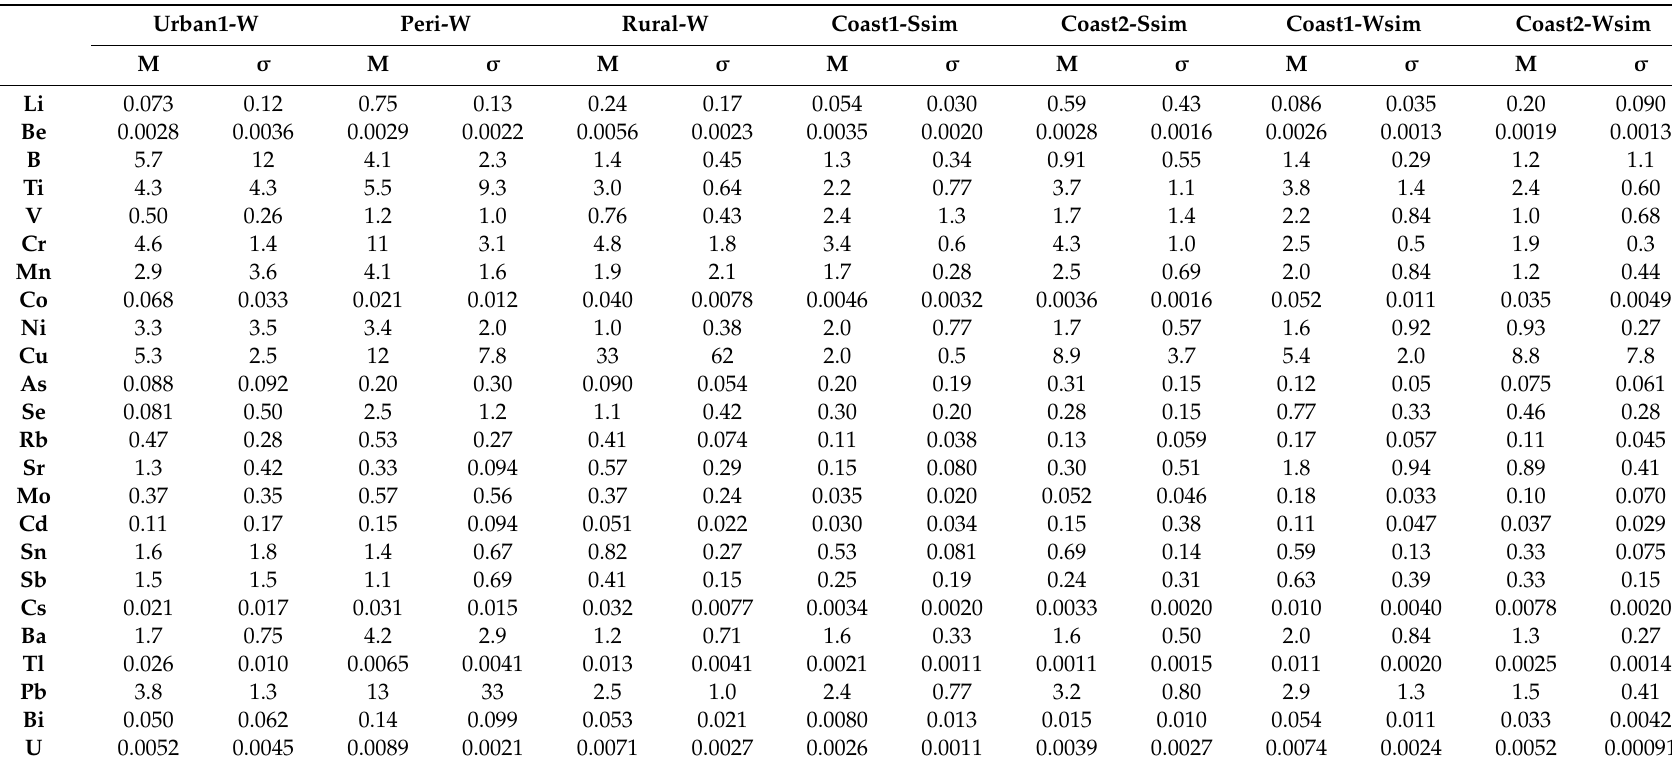
Table A2. Average mass concentrations (M) and standard deviations ( σ ) (in ng / m 3 ) of the residual micro- and trace-components measured indoors. * < LOD indicates a value below the limit of